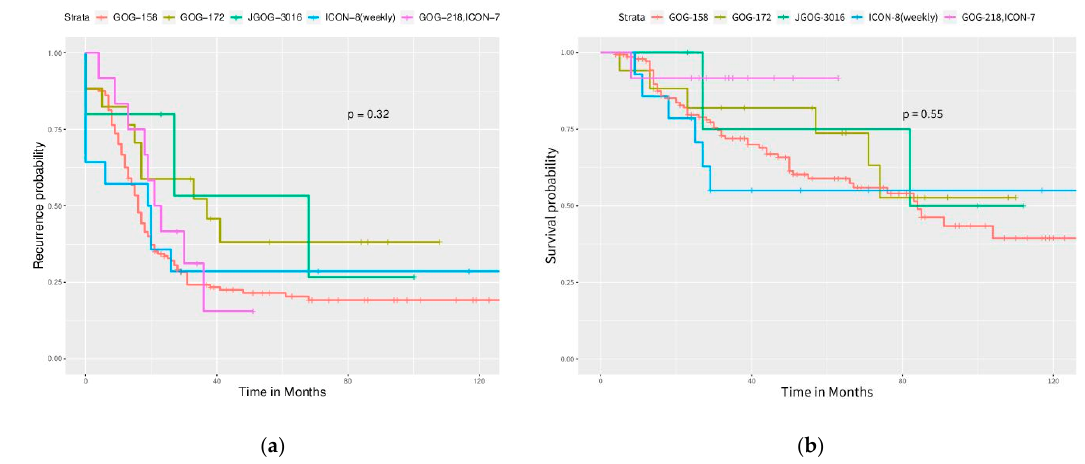
Figure 4. Survival curves by the LN status (All enrolled cases) ( a ) PFS, p < 0.0001, ( b ) OS, p = 0.0022. LN dissection provided better outcome of all enrolled cases, no matter how LN status was.